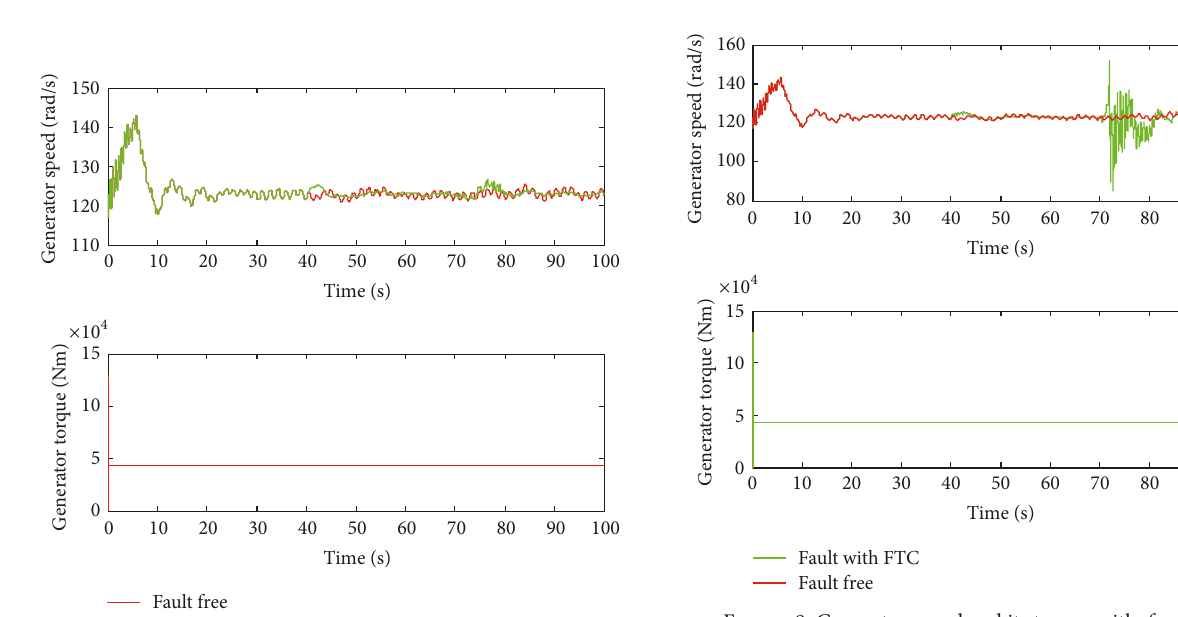
Figure 6: Generator power output with 𝑓 𝑠 = − 0.2.